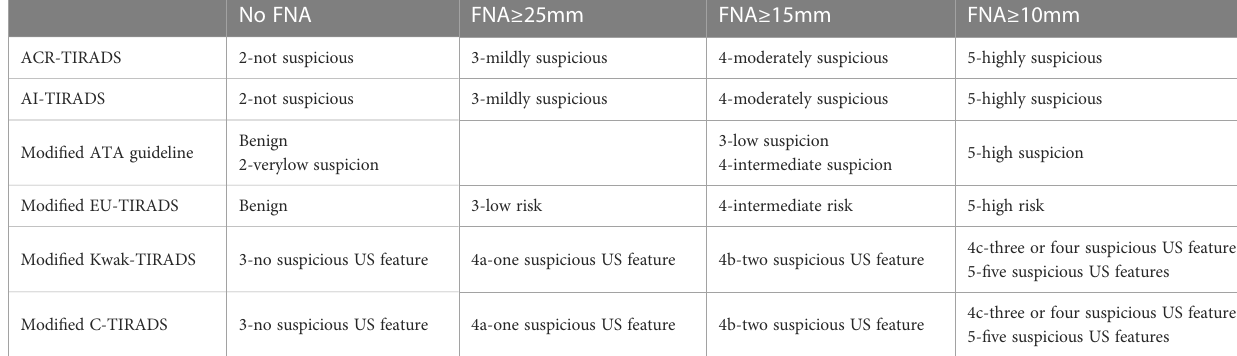
TABLE 1 The uniform size thresholds suggested by ACR-TIRADS for fi ne-needle aspiration in the six risk strati fi cation systems. No